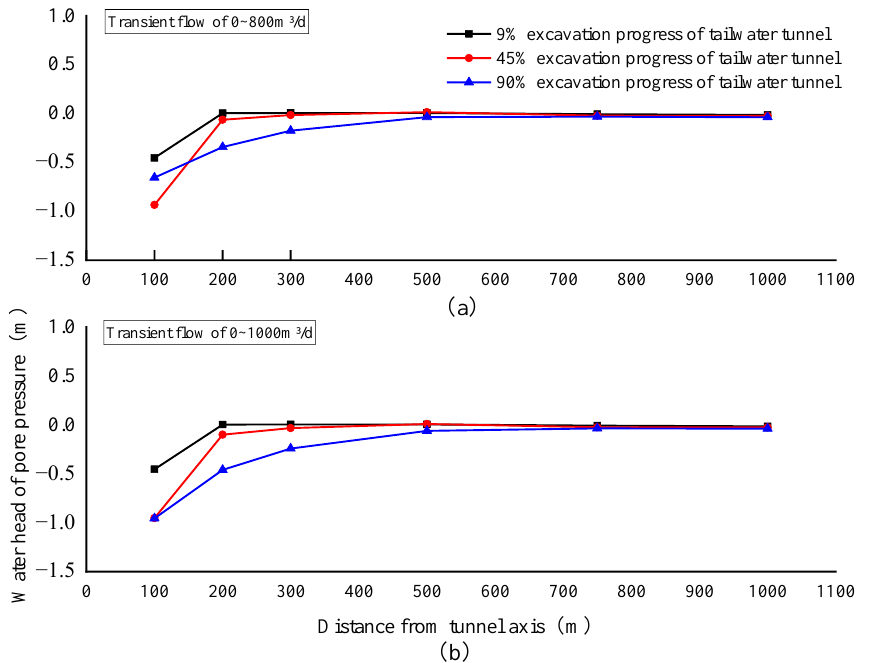
Figure 14. Variations in the water level under normal seepage conditions. (( a ) is change in water level of the maximum water inflow of 800 m³/d, ( b ) is change in water level of the maximum water inflow of 1000 m³/d).